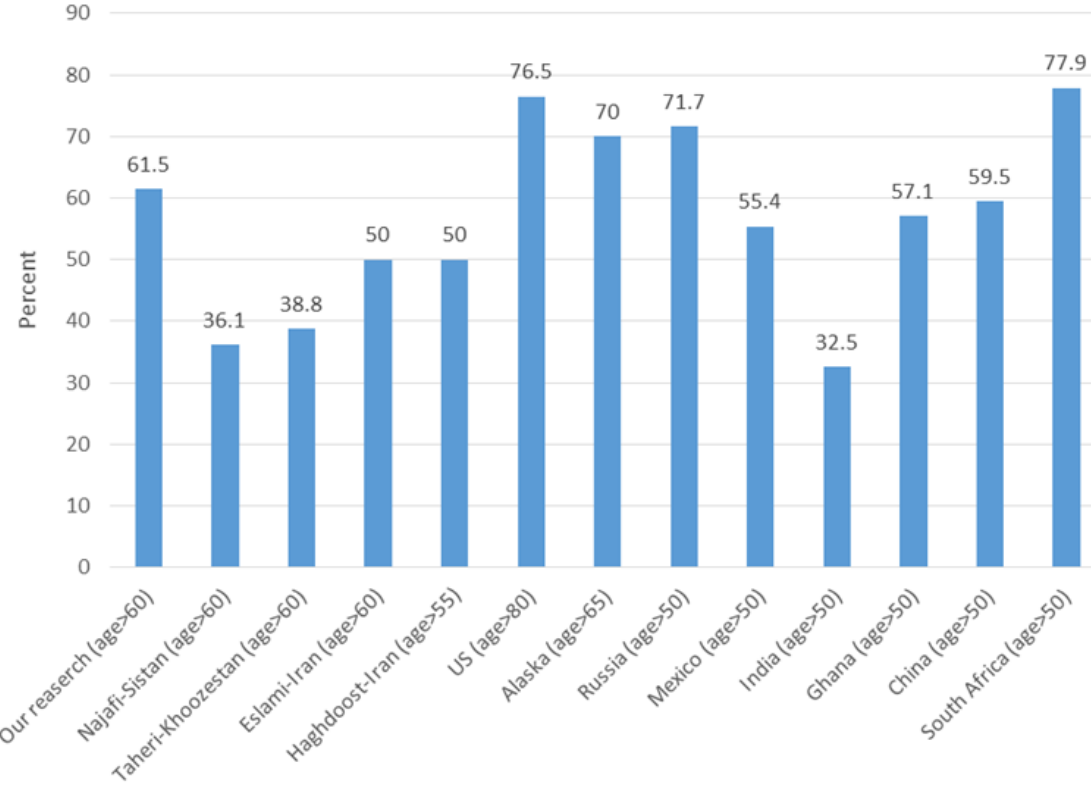
Figure 2: Prevalence of hypertension in the elderly in some parts of the world compared with this